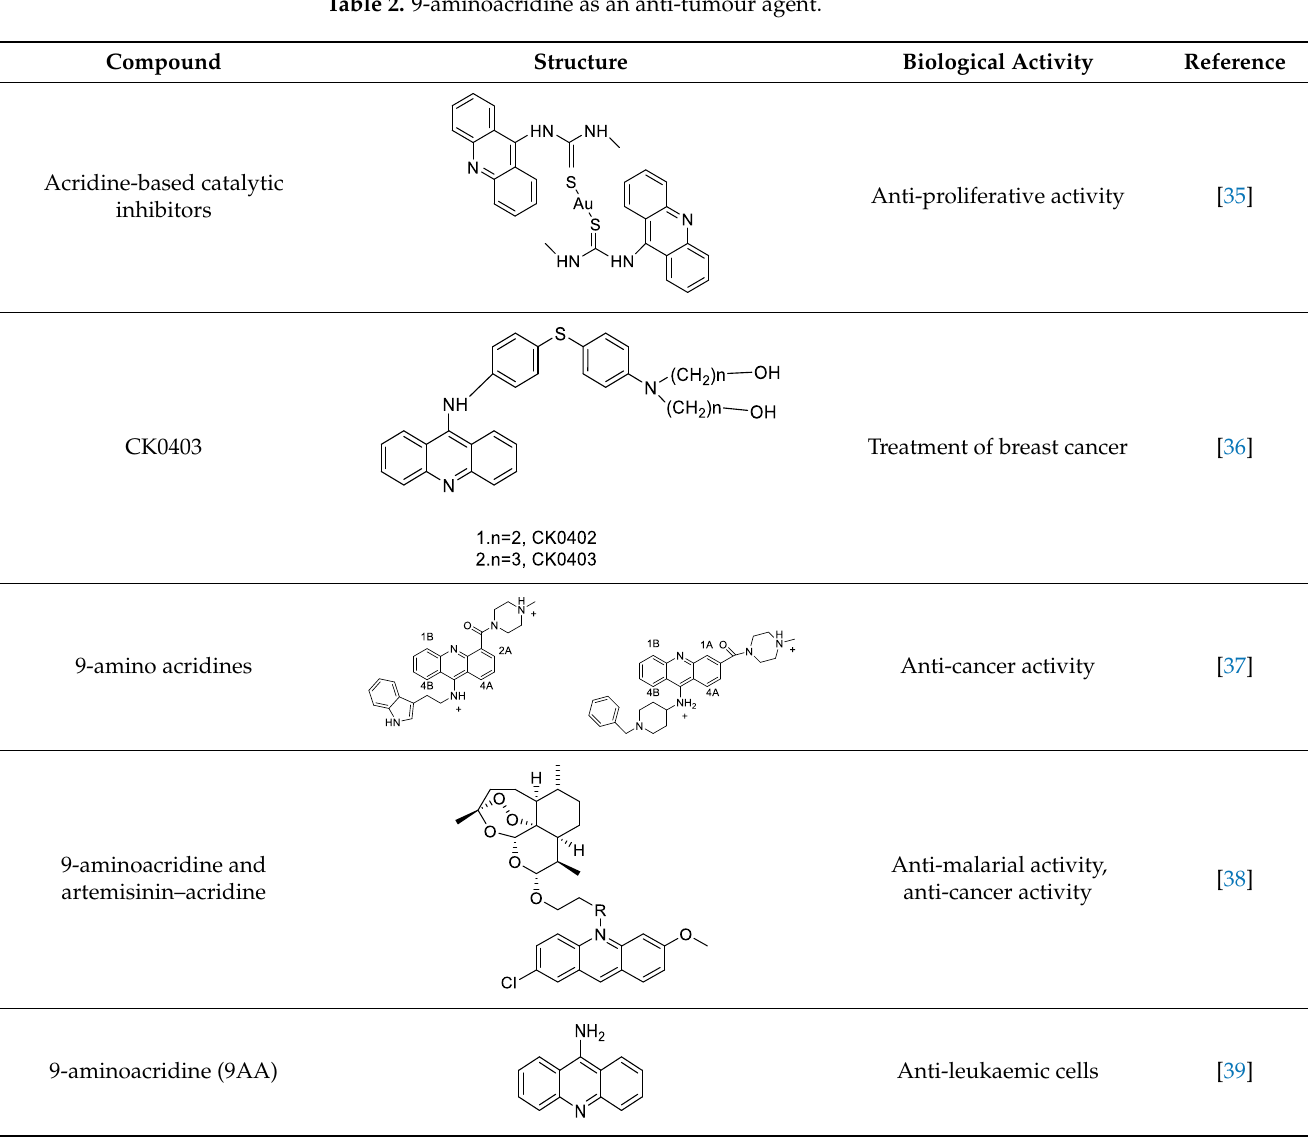
Figure 4. Multi-step synthesis of artemisinin – acridine hybrids and their derivatives. Table 2. 9-aminoacridine as an anti-tumour Table 2. 9-aminoacridine as an anti-tumour agent.